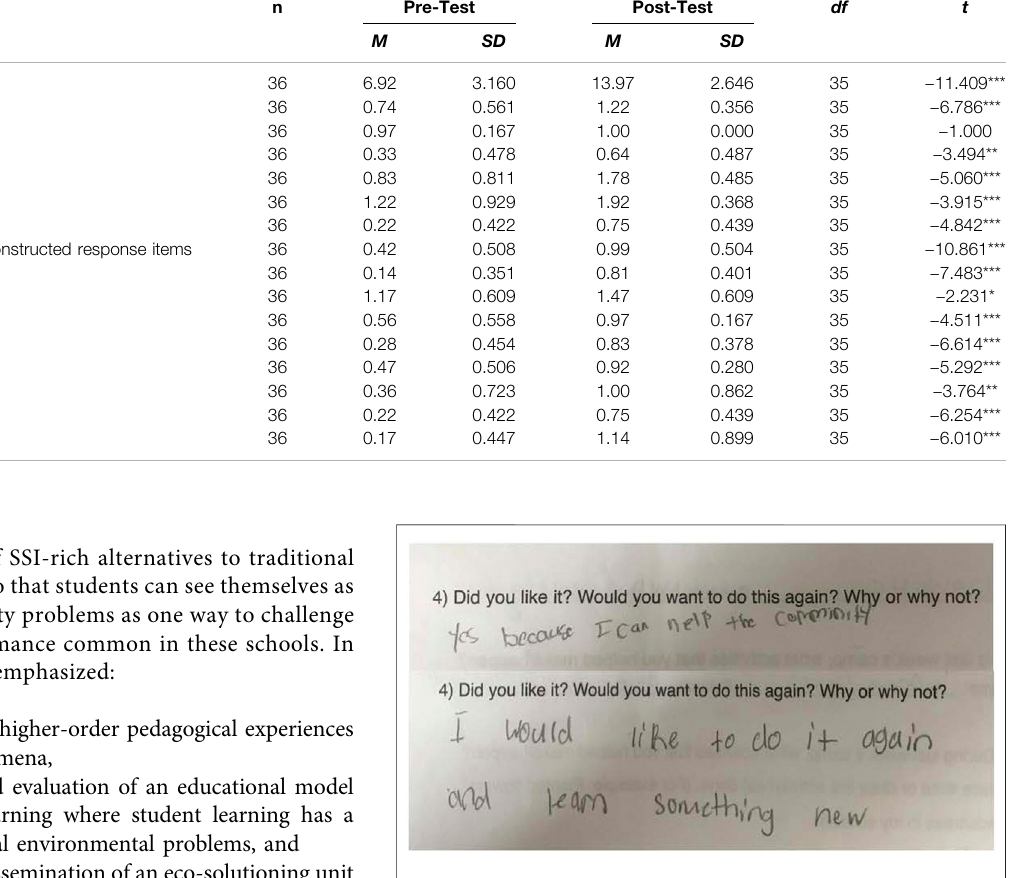
TABLE 5 | Descriptive Statistics and T-Test Results for Pre and Post Tests (Cycle 2) Outcome n Pre-Test Post-Test